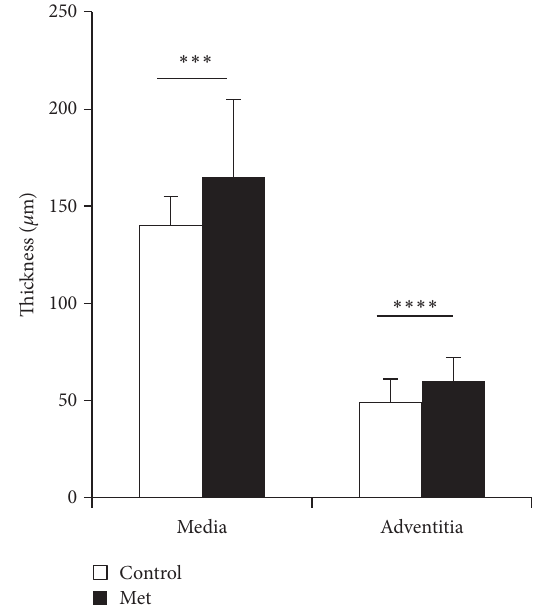
Figure 9: Aorta morphometry of newborn rabbit ( ∗∗∗ 𝑝 < 0.001 ; ∗∗∗∗ 𝑝 < 0.0001 ).